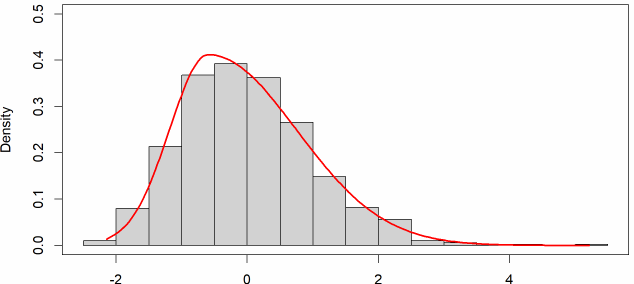
Figure 4. Generalized Error